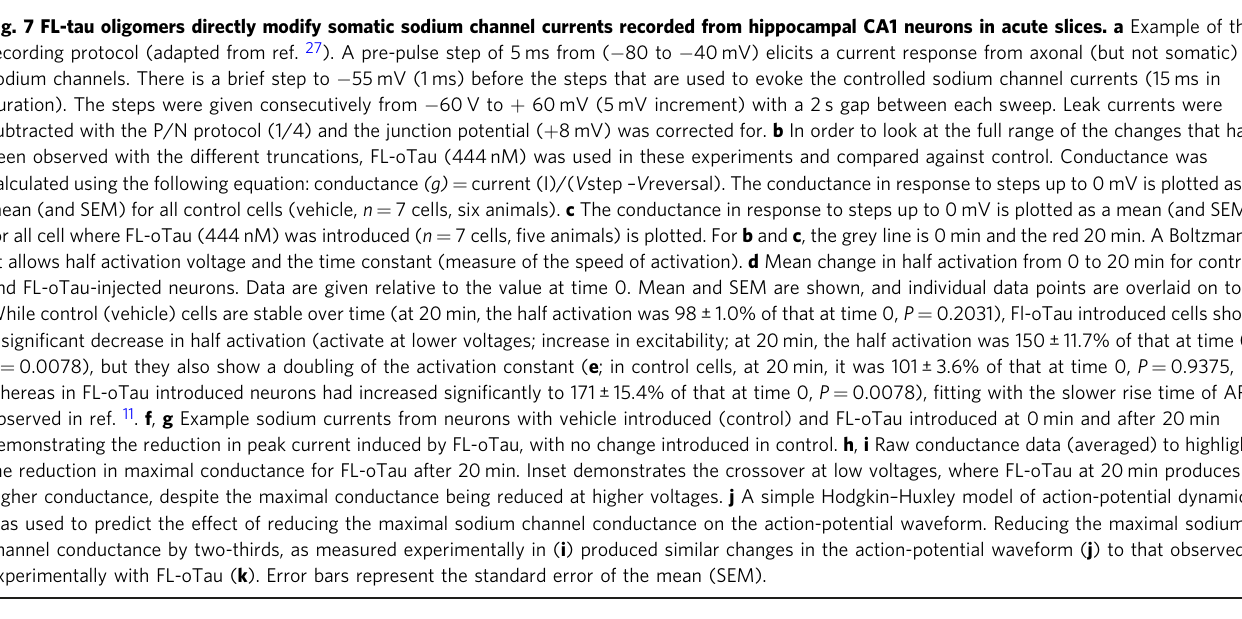
Fig. 7 FL-tau oligomers directly modify somatic sodium channel currents recorded from hippocampal CA1 neurons in acute slices. a Example of the recording protocol (adapted from ref. 27 ). A pre-pulse step of 5 ms from ( − 80 to − 40 mV) elicits a current response from axonal (but not